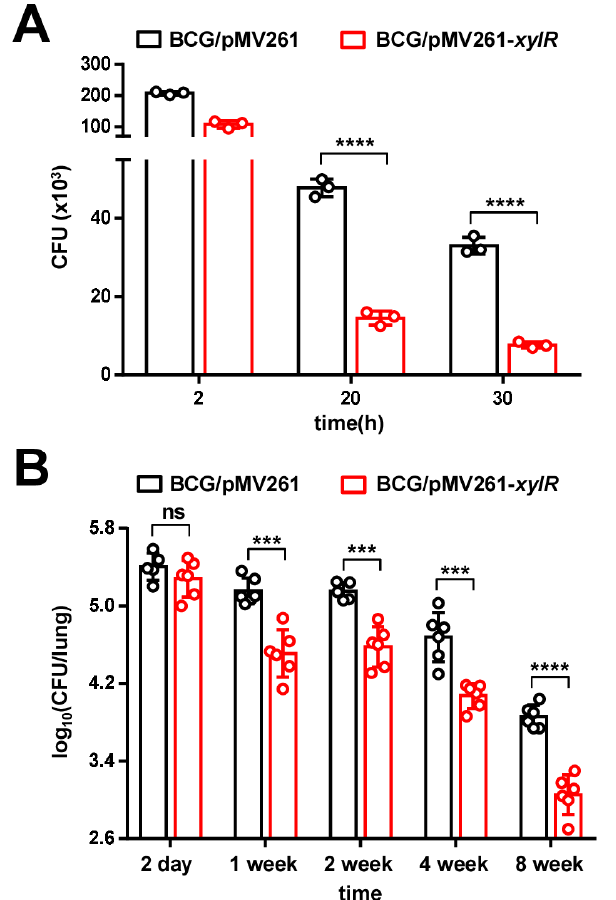
Figure 8. Assays for testing the effect of XylR on intracellular survival of mycobacteria in the host. ( A ) Detection of BMDMs intracellular survival efficiency infected with BCG/pMV261 strain and BCG/pMV261- xylR strain, respectively. Error bars represent the S.D. from three biological experiments. ( B ) Detection of the mycobacterial burdens in the lungs of C57BL/6 mice infected with the BCG/pMV261 strain and BCG/pMV261- xylR strain, respectively. Error bars represent the S.D. from six biological experiments. Statistical analysis was carried out using multiple Student’s t -tests. The P -values of the results (< 0.001, < 0.0001) are indicated by asterisk ( *** , **** ) on top of the column in the fi gure. Not signi fi cant change ( P > 0.05) is indicated by ns.